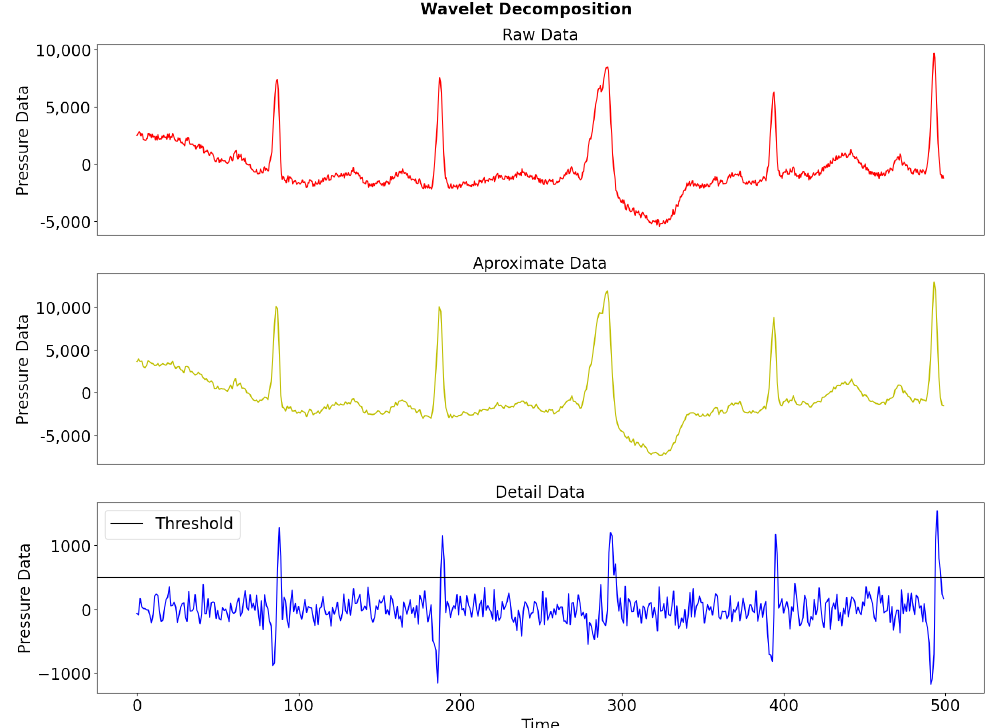
Figure 2. Detection of break points in details data by wavelet decomposition.